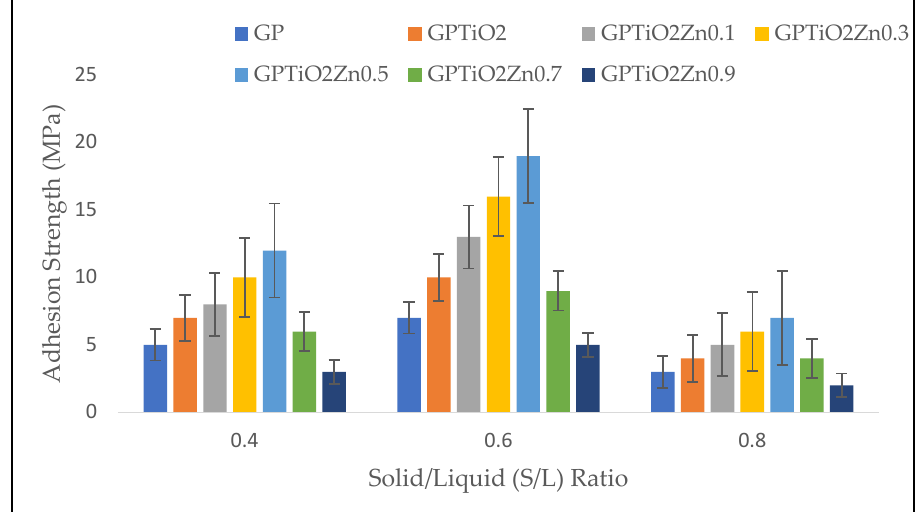
Figure 4. Adhesion strength of metakaolin geopolymer coating with various S/L ratios. Figure 5 demonstrated the metakaolin geopolymer ‐ coated sample with failure at S/L ratio of 0.6 for GP, GPTiO 2 Zn0.5, and GPTiO 2 Zn0.9. Coating samples with the highest and lowest adhesion strength together with GP as control sample were analyzed to learn which factors contributed to their respective performances.